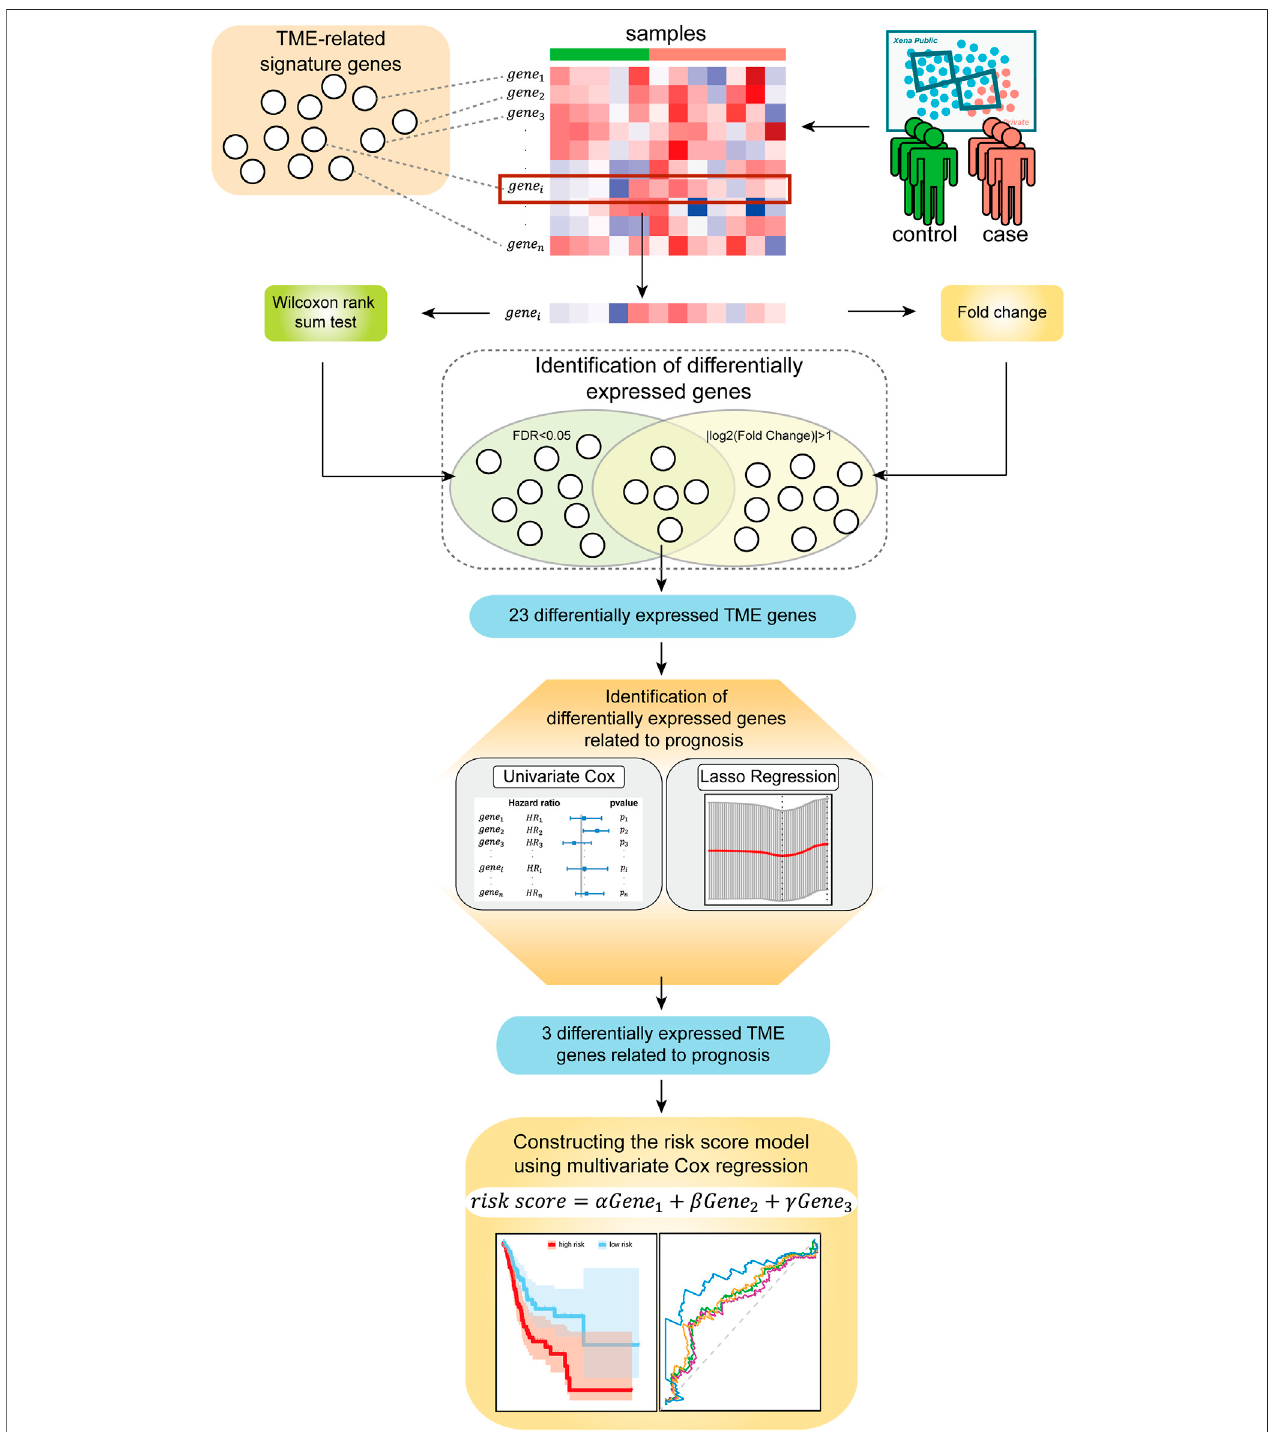
FIGURE 1 | Flow diagram of the